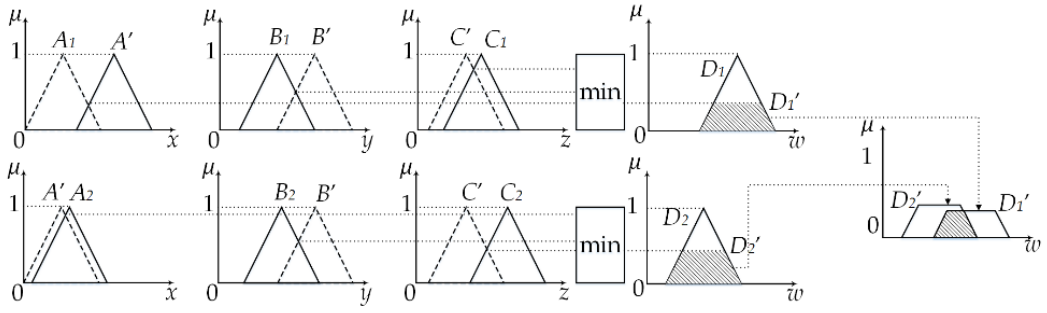
Figure 4. Three-input two-rule reasoning.